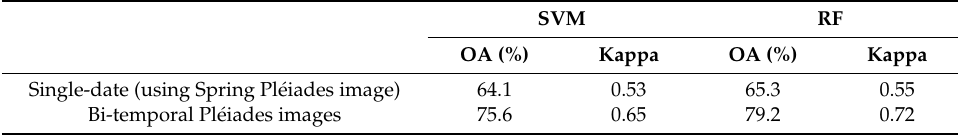
Table 4. Accuracy measures for the urban tree species classification using SVM and RF with single-date and bi-temporal Pl é iades images. SVM: Support Vector Machine; RF: Random Forest; OA: Overall Accuracy.